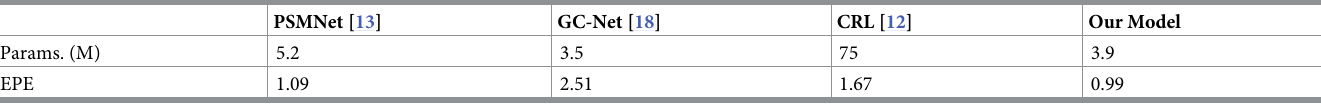
Table 4. Comparison of the EPEs of different networks on the Scene Flow